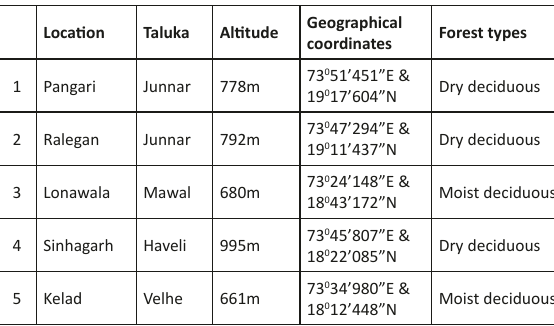
Table 1. Locations at which the observations are recorded.